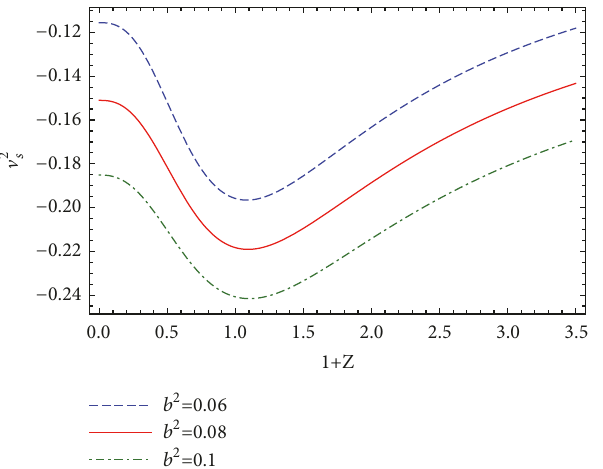
Figure 15: The evolution of the statefinder parameter 𝑠 versus the redshift parameter 𝑧 for interacting GDE in the DGP model. Here, = 0.0003 . we have taken Ω 𝐷 (𝑧 = 0) = 0.73 , 𝐻(𝑧 = 0) = 67 , and Ω 𝑟 𝑐